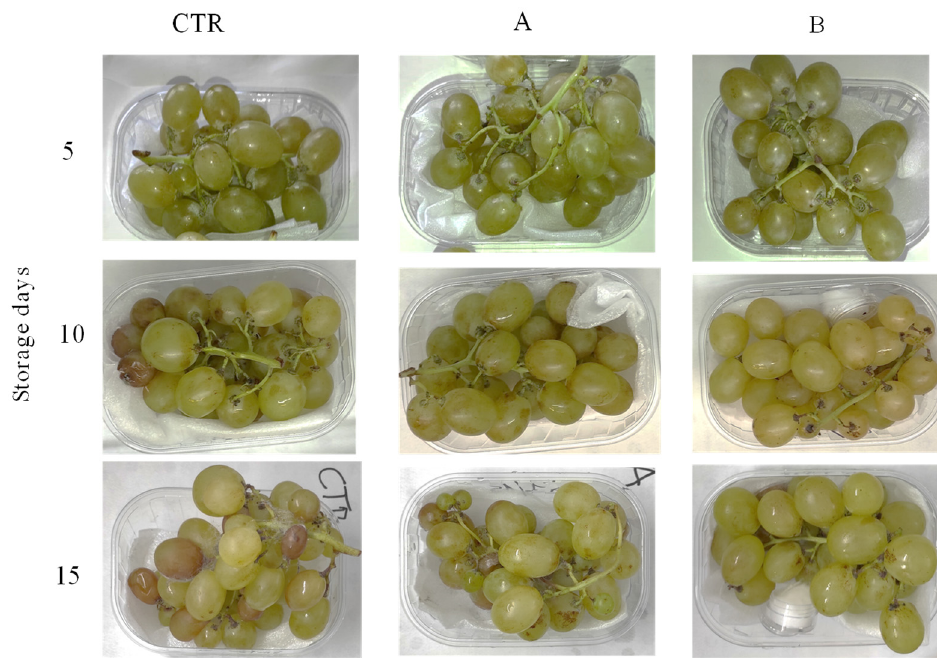
Figure 3. Inoculated table grapes (cv. Italia) packed in HDPE bags with different citral doses (A equal to MIC value of 0.0125 μ L/cm 3 and B equal to 4-fold MIC value of 0.05 μ L/cm 3 , respectively) and stored at 12 °C and 85% relative humidity for 15 days. CTR: control without citral. Bars are means ± standard deviations ( n = 3).